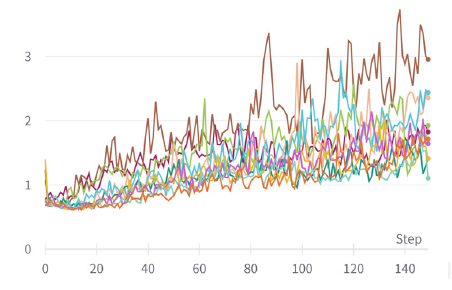
Figure 7. Learning curves (loss) of the iterations of the hyperparameter optimization.